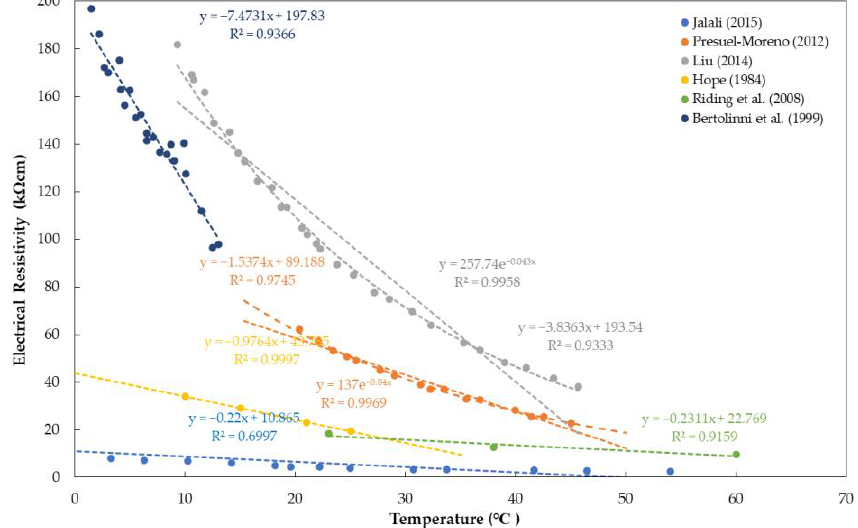
Figure 6. Summary of references showing the relationship between electrical resistivity and concrete temperature .